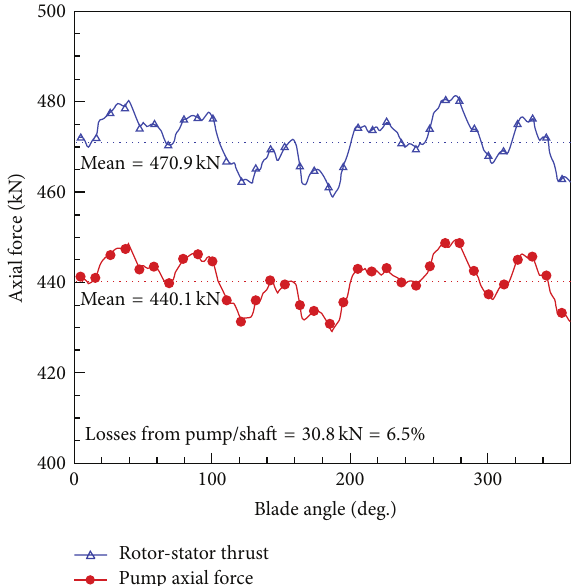
Figure 18: Comparison of total axial force on the rotor and stator blades compared to the entire waterjet system.